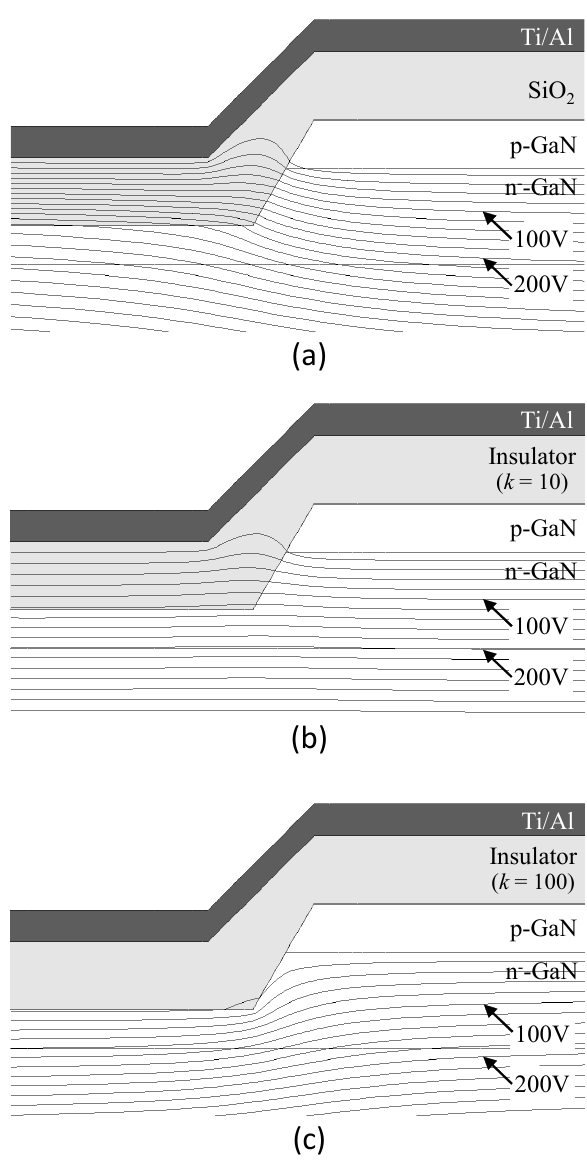
Figure 2. Simulation result at the mesa and peripheral: ( a ) k = 3.9 (SiO 2 ); ( b ) k = 10; ( c ) k = 100.